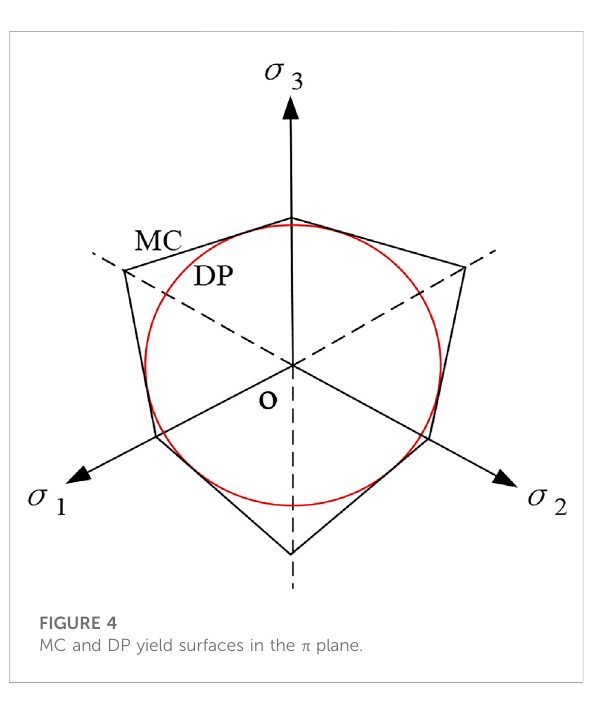
MCC yield surface in the q - p